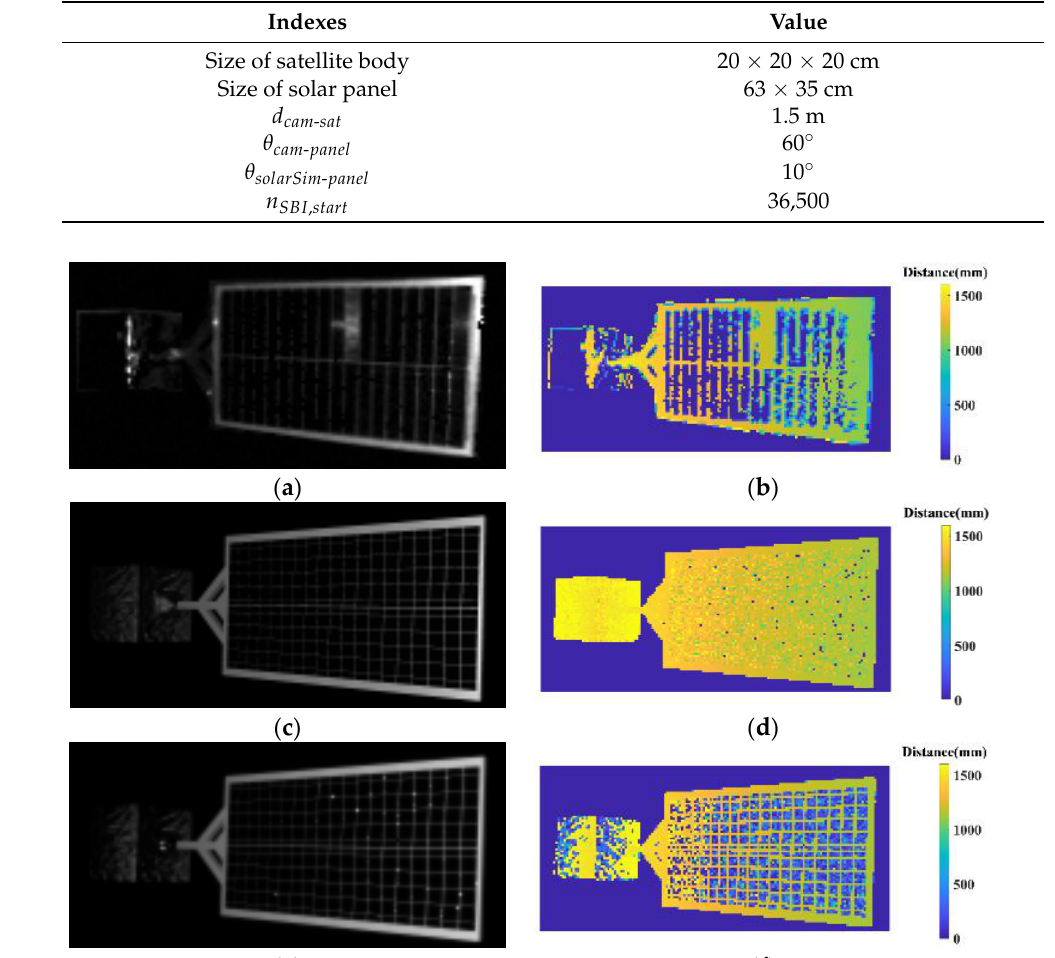
Table 4. Other simulation parameters used.